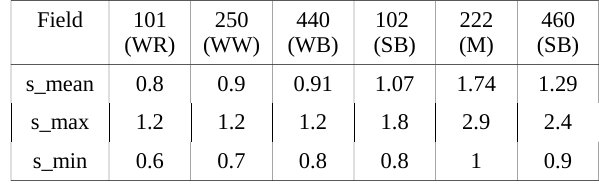
Table 1. Statistical values of in-field ks values .